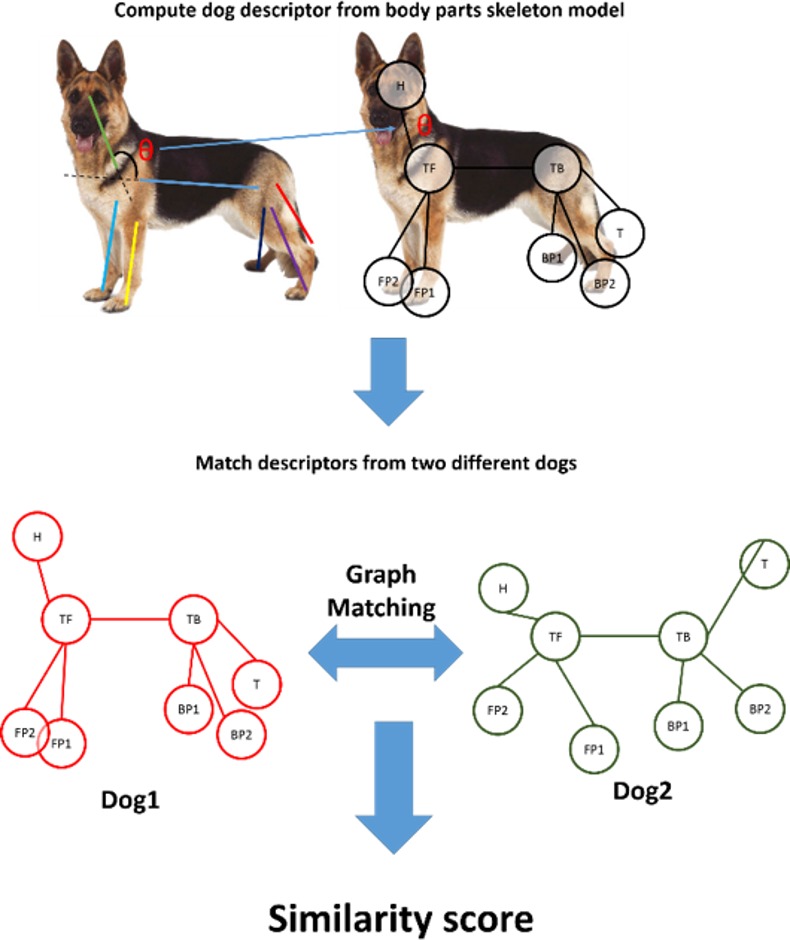
Comparison between different frames of the dog skeleton.For each frame a descriptor score for the dog skeleton is computed (top). Then, all the descriptors (from the same or different dogs) are compared and matched. The NW algorithm creates the similarity scores and aligns the segments.